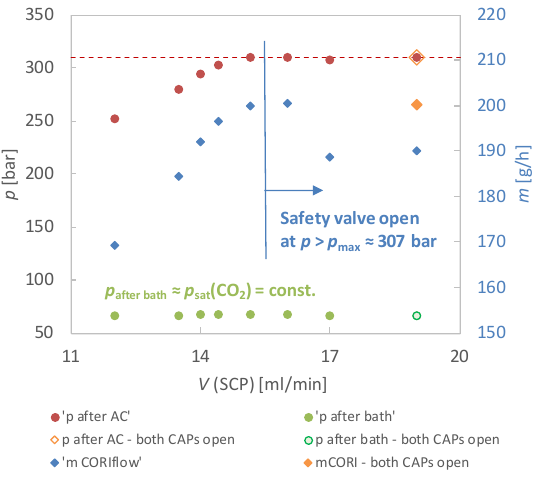
Fig. 4. Settings of safety valve installed on accumulator (AC) for a maximum pressure of 307 bar.